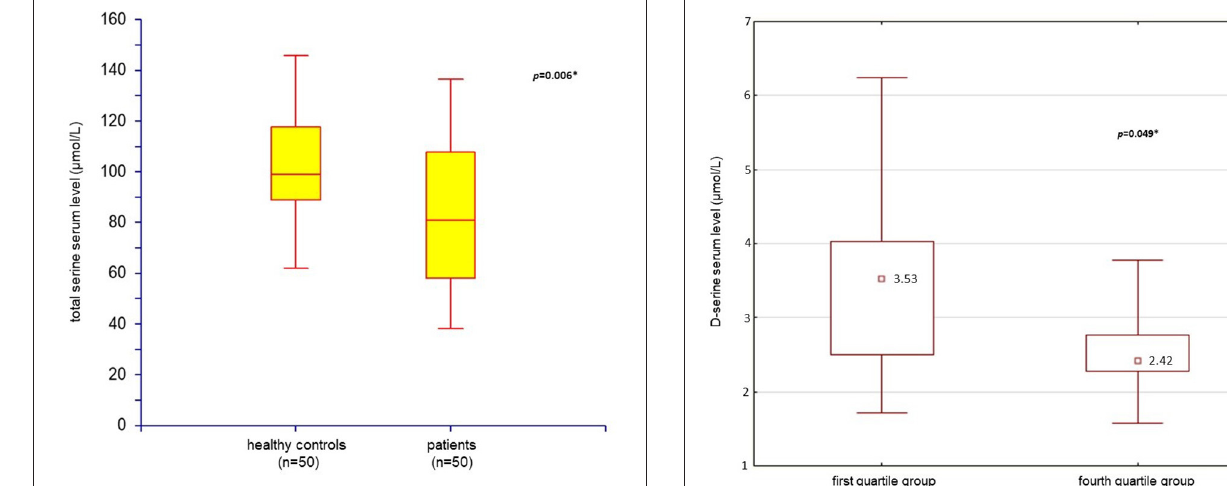
FIGURE 3 | D-serine serum level (median; µ mol/l): comparison of first quartile group (the best performance in executive function testing, the summary index 2; n = 12) and 4th quartile (the worst performance, the summary index 2; n = 12) of patients’ population ( n = 50) (Mann-Whitney U -test; * p < 0.05 was considered as significant).